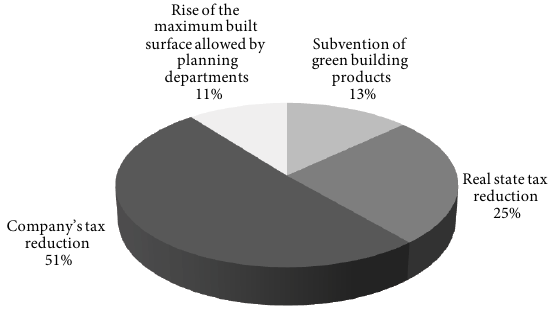
Fig. 5. Financial incentives that would promote the implementation of SC practices in building construction